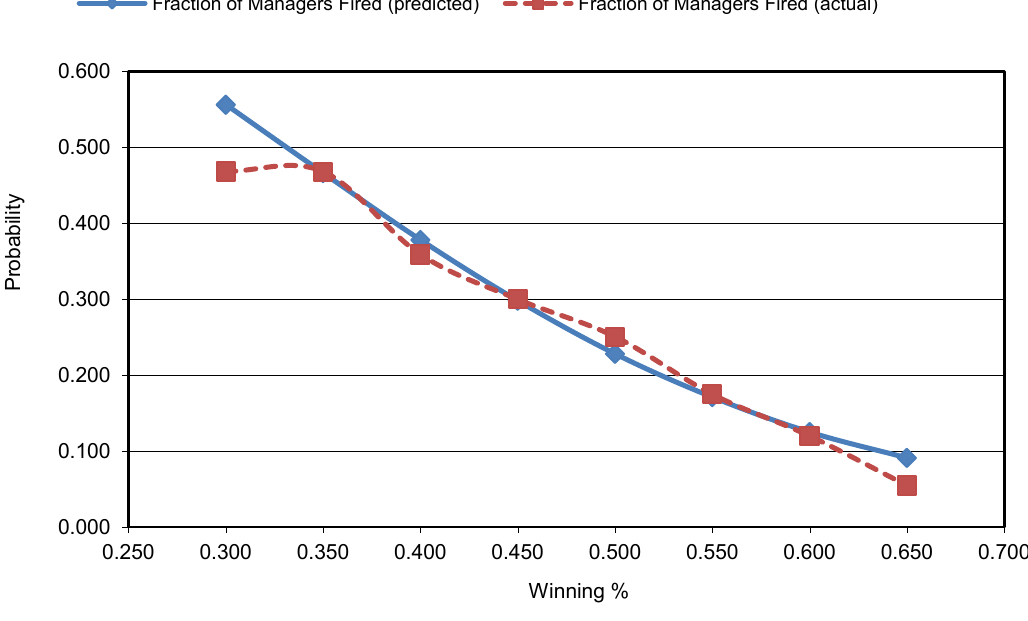
Figure 1. Probability that a Major League Baseball manager will be fired Fraction of Managers Fired (predicted)